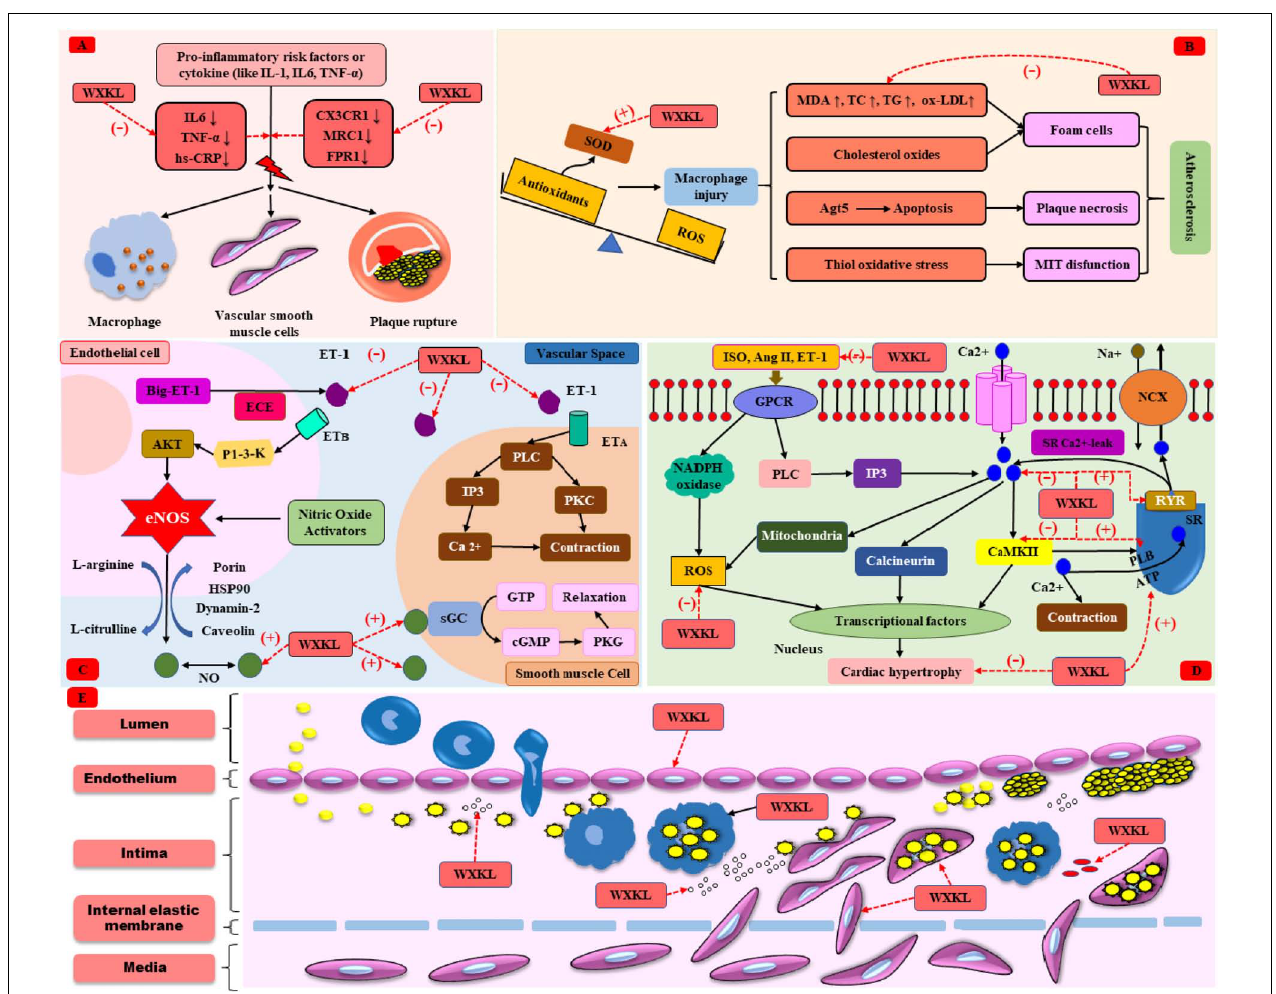
FIGURE 2 | The cardioprotective mechanism of WXKL. (A) Anti-inflammation. (B) Anti-oxidative stress. (C) Regulation of vasomotor. (D) Anti-cardiac hypertrophy. (E)